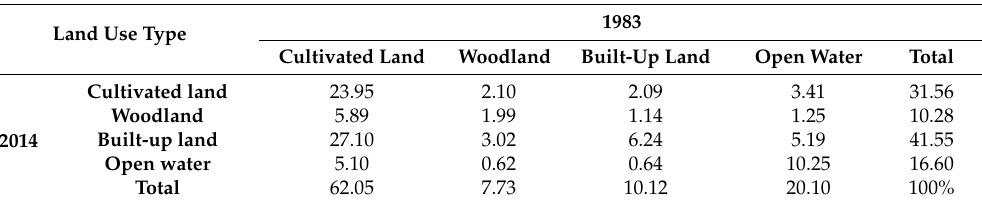
Table 2. Transfer matrix of land use (%). Each cell in the matrix represents how land cover changed between two land use types between 1983 and 2014.